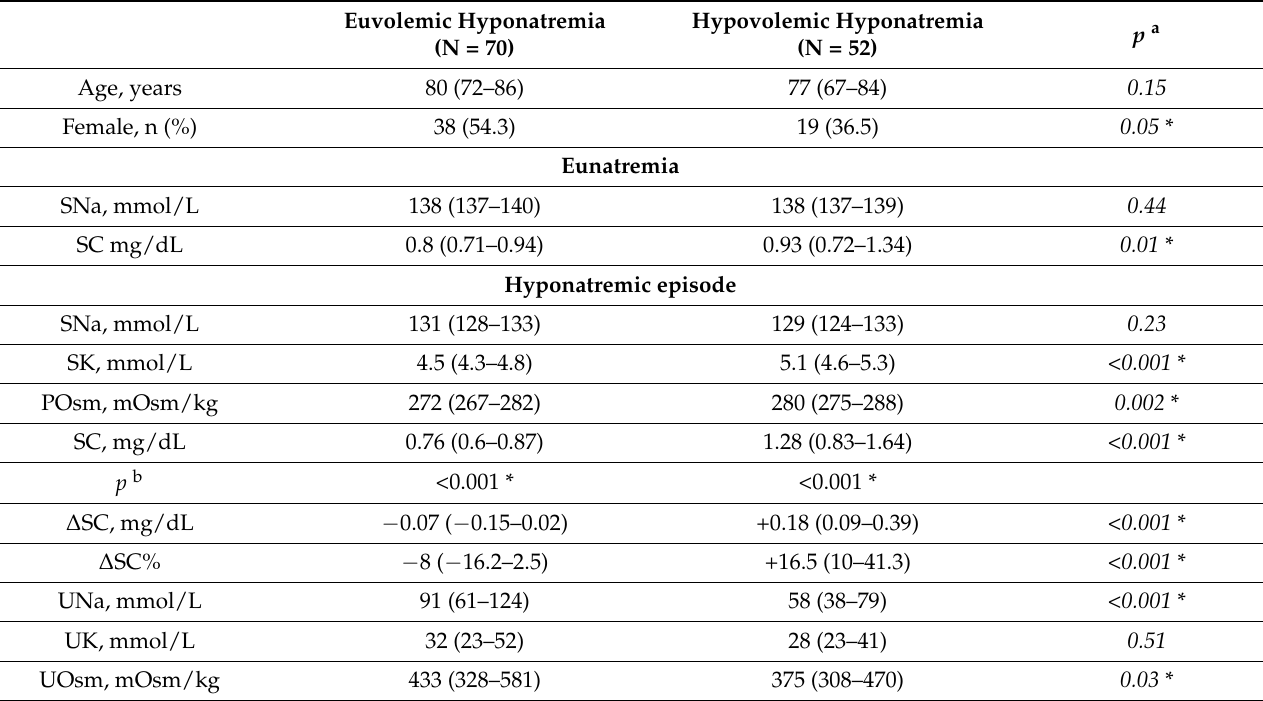
Table 2. Patients’ parameters in eunatremia and hyponatremia as classified by volemic status when hyponatremic. Euvolemic